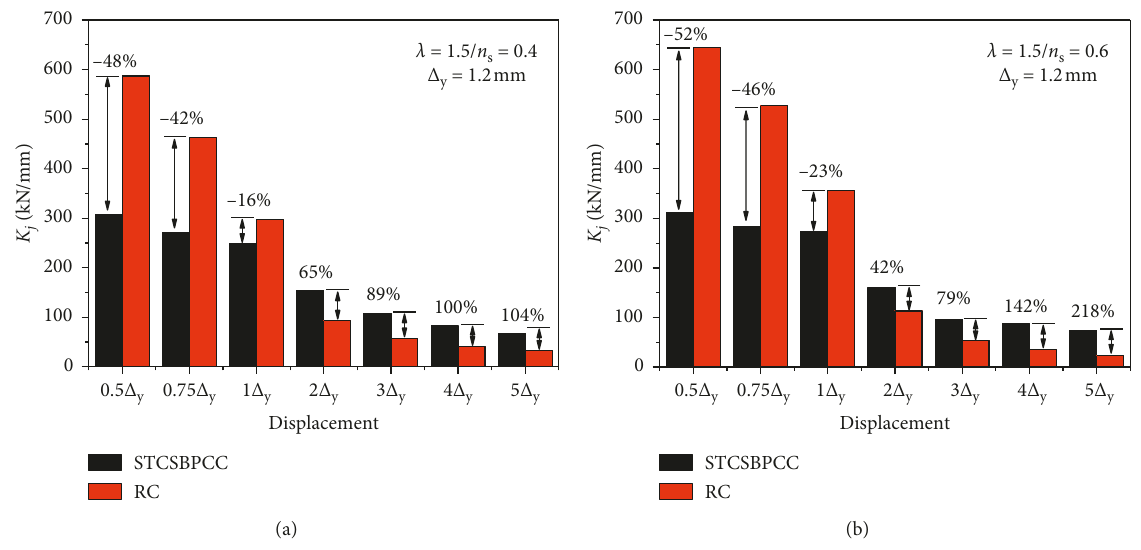
Figure 25: Stiffness columnar analysis diagram. (a) n